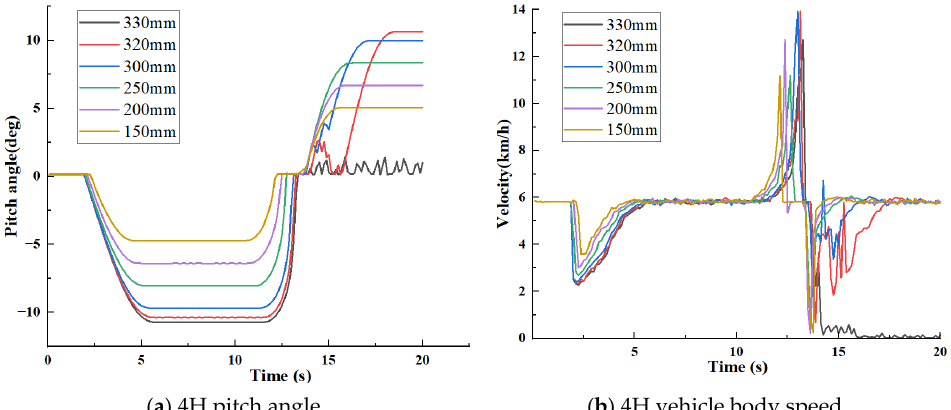
Figure 9. Simulation results of 4H ridge crossing.